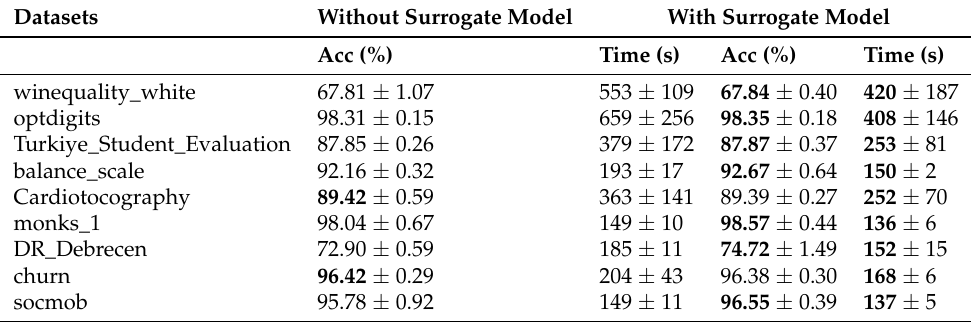
Table 7. The performance (mean ± std) of PPO with surrogate model and without surrogate model.